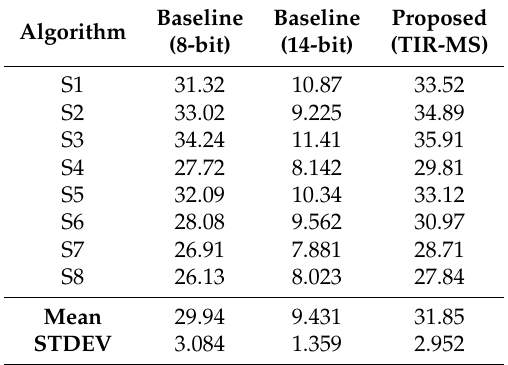
Table 6. Comparison of tracking speed: frame per second